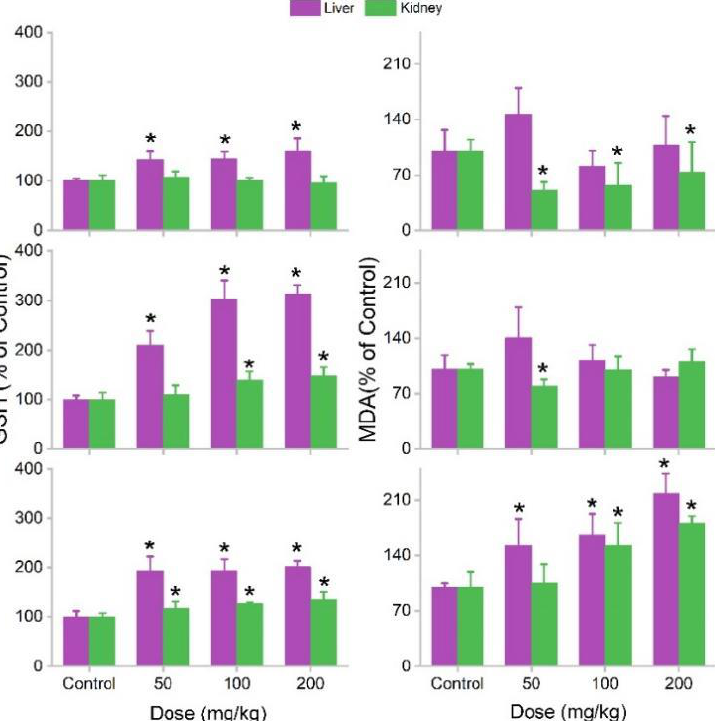
Figure 7. Oxidative stress of liver and kidneys after exposure to MOF-74(Co) ( n = 4). * p < 0.05 compared to the control group.